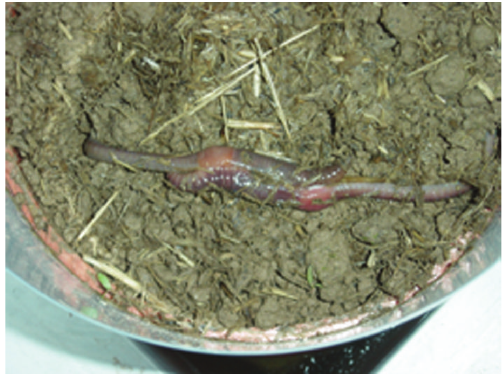
Figure 11: A pair of mating L. terrestris on the soil surface, revealed and photographed after sun rise.